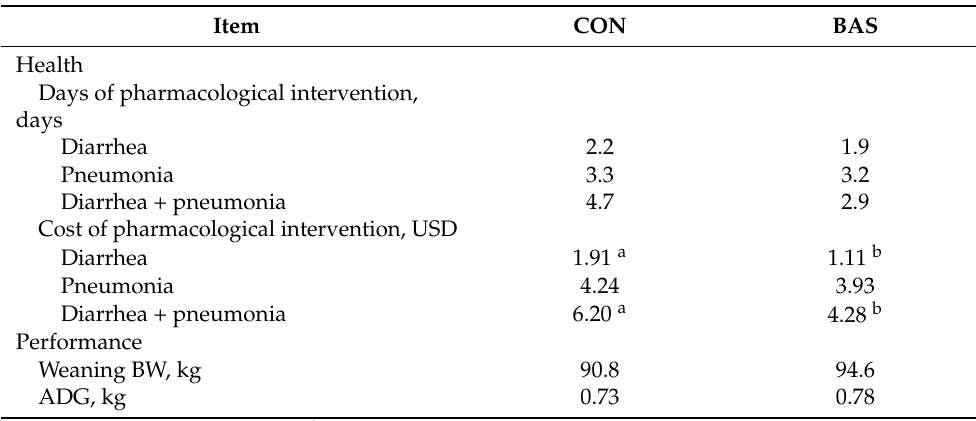
Table 7. Days of pharmacological intervention, cost per pharmacological intervention, and perfor- mance of female Gir × Holstein dairy calves receiving (BAS) or not (CON) a bovine appeasing substance every 14 days during pre-weaning 1,2 . Item CON